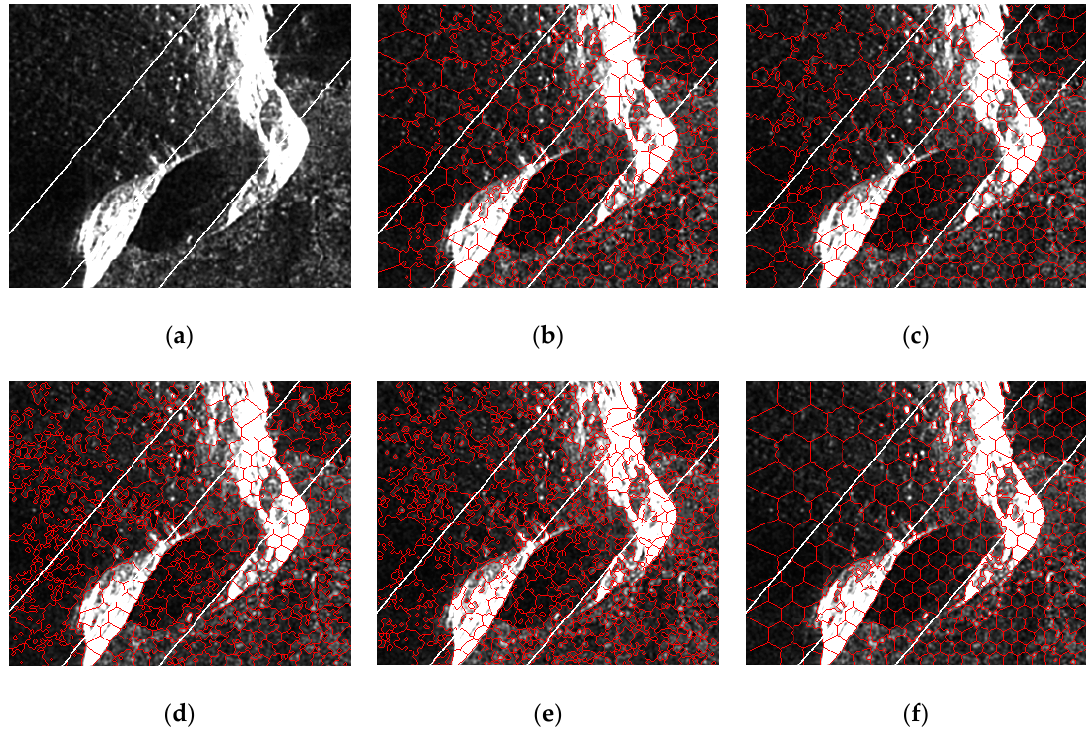
Figure 17. Resulting superpixels of Ayers Rock with m set to five and K set to 100, 200, 400, and 600 for regions A, B, C, and D. ( a ) Original SAR image; ( b ) SLIC; ( c ) PILS; ( d ) LBSLIC; ( e ) PBSLIC; and ( f ) PSDSD.